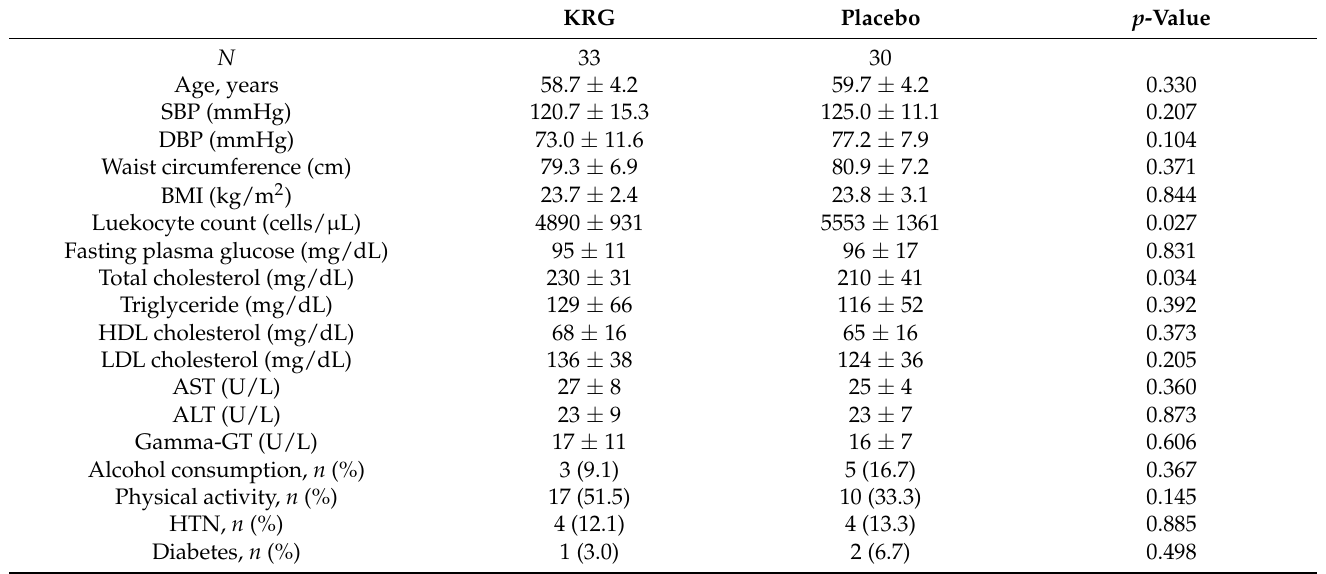
Table 1. Baseline characteristics of study